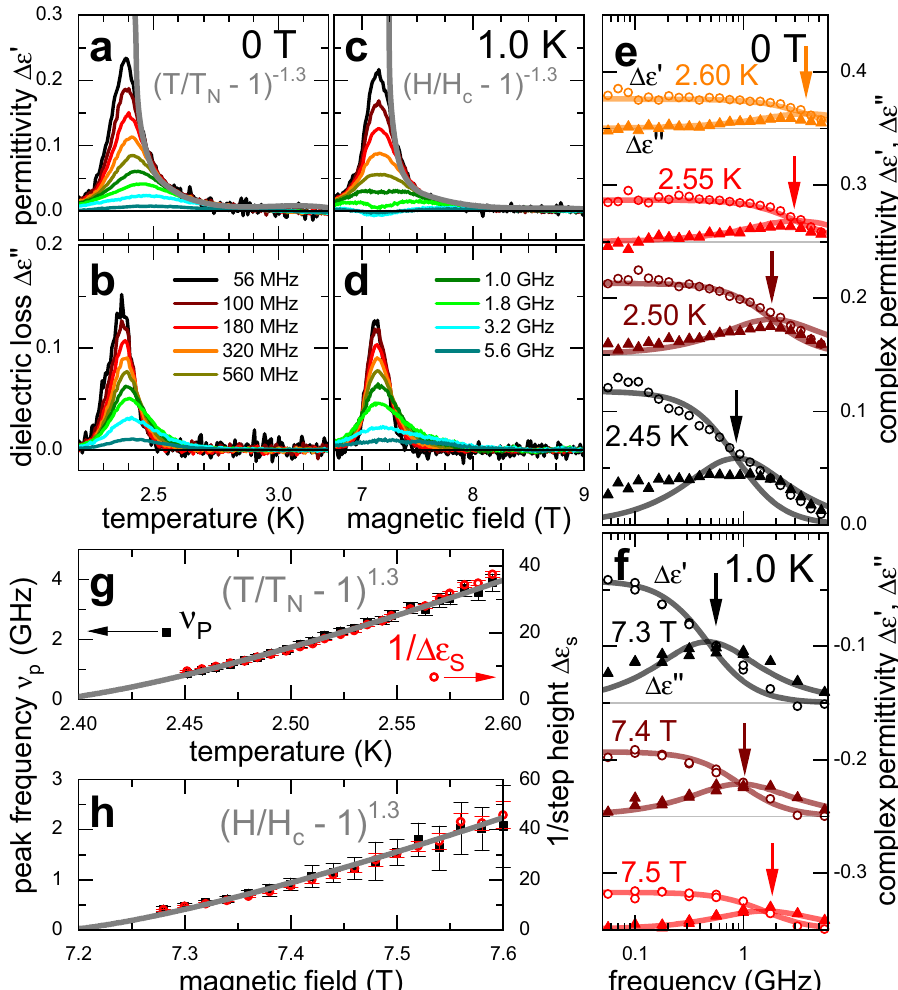
Fig. 2 T- and H- dependent critical dynamics of thermally activated fl uctuations. Real and imaginary part of the complex permittivity in the frequency range of 56 MHz – 5.6 GHz from temperature ( T ) dependent measurements in zero magnetic fi elds are shown in a , b and magnetic fi eld ( H ) dependent measurements at 1.0 K are shown in c , d . Contributions of faster polarization effects have been subtracted. In e , f the measured permittivity spectra (circles for Δ ε 0 ð ν Þ and triangles for Δ ε ″ ( ν )) are shown with the fi tted Debye relaxation as solid lines for the T − and H − dependent measurements respectively. Here, the spectra are offset for enhanced visibility and the peak positions in the dielectric loss are marked by arrows. The T − (in g ) and H − dependence (in h ) of the parameters ν p and 1/ Δ ε s can be described with a critical dynamical exponent of 1.3. The error bars in g , h represent the root mean squared error obtained for the fi ts of the Debye